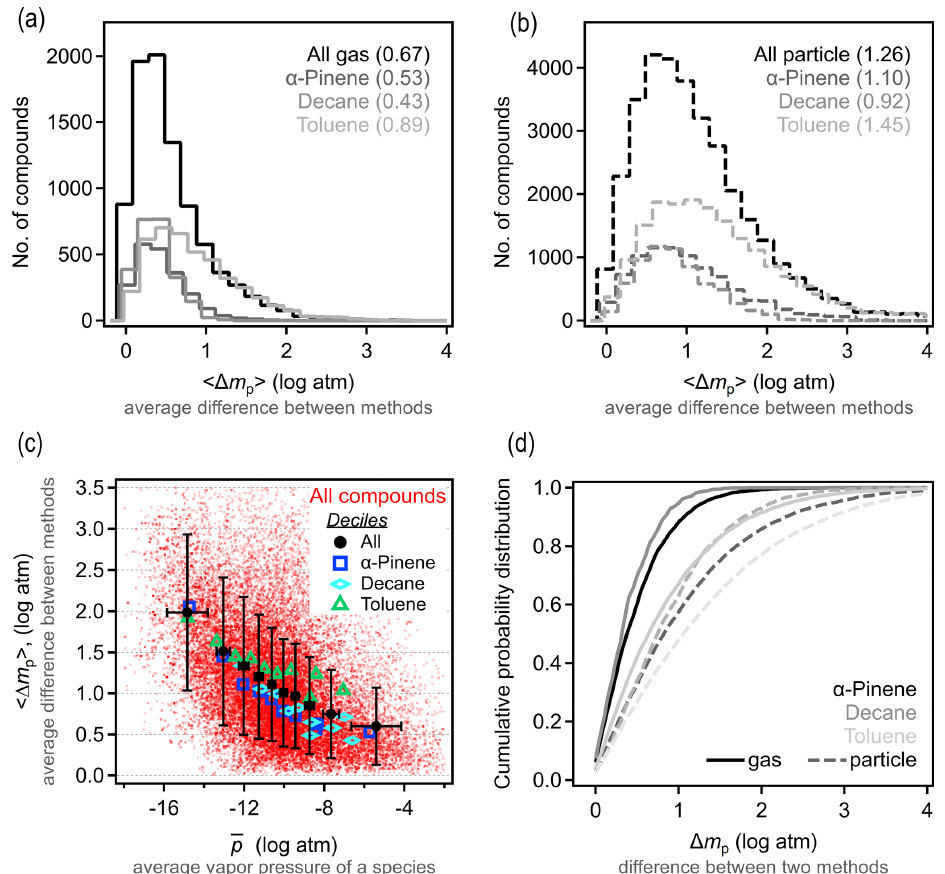
Figure 2. Differences in vapor pressures between the Nannoolal, SIMPOL, and EVAPORATION estimation methods. (a) Distribution of (cid:104) (cid:49)m p (cid:105) , the average difference between vapor pressures estimated for a given compound in the (a) gas and (b) particle phase, with each oxidation system shown in a different shade. Average values of each distribution are provided in parentheses. (c) Distribution of (cid:104) (cid:49)m p (cid:105) as a function of vapor pressure (as the average vapor pressure of a species, p ), broken out by oxidation system. Red dots are individual species; larger markers and error bars are the average and standard deviation of deciles. (d) Cumulative probability distribution of (cid:49)m p , which is the difference between any two methods for given